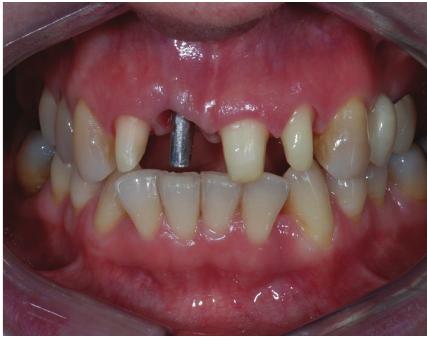
Figure 23: Frontal view before prostheses delivery. The implant abutment was tested before extraoral cementation of the crown.